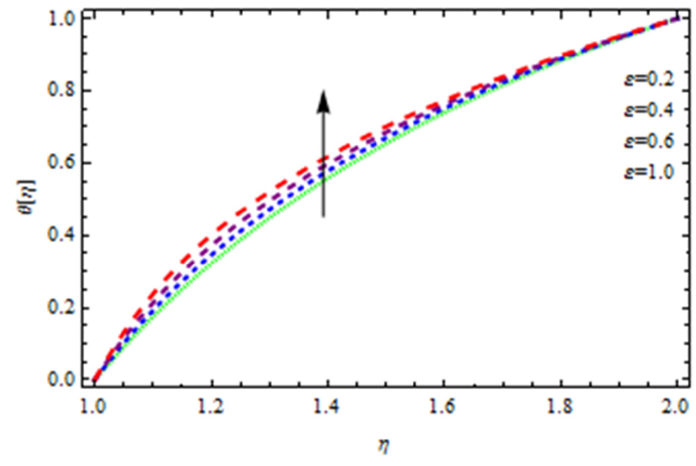
Figure 15. Temperature distribution in the Reynolds model for ϵ .